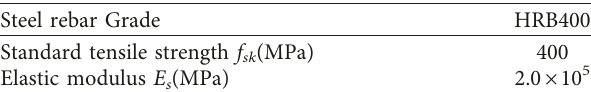
Table 2: Mechanical properties of steel